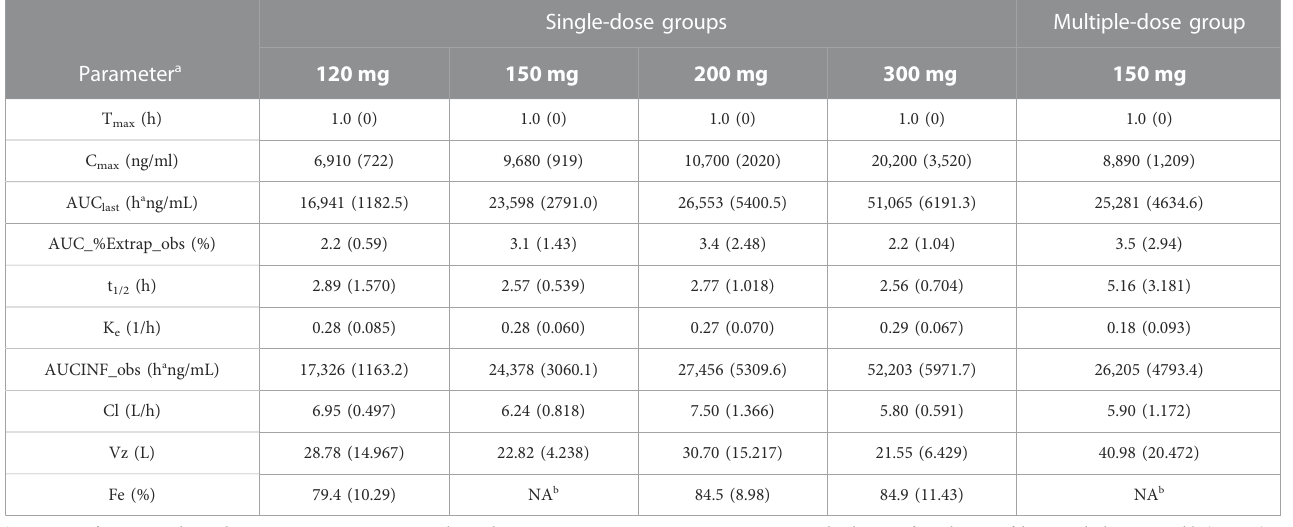
TABLE4Pharmacokineticparameters(mean(SD), n =6)ofetimicininChinese HVsafterasingle dose(120 mg,150 mg,200 mg,300 mg)andmultiple doses(150 mg).